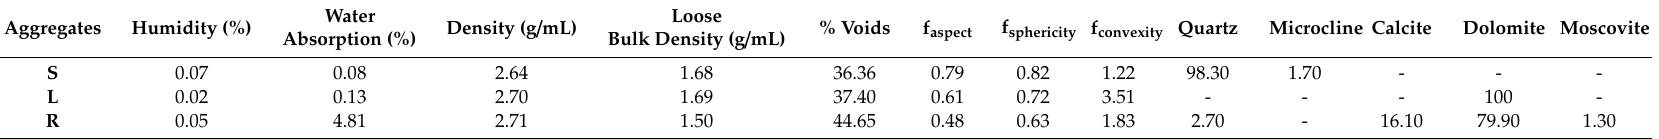
Table 4. Physical and morphological properties of siliceous (S), limestone (L), and recycled aggregates (R) ( D max 2 mm). Quantitative mineralogical composition (wt.%) of S, L, and R aggregates. Quantitative mineralogical composition (wt.%) of S, L, and R